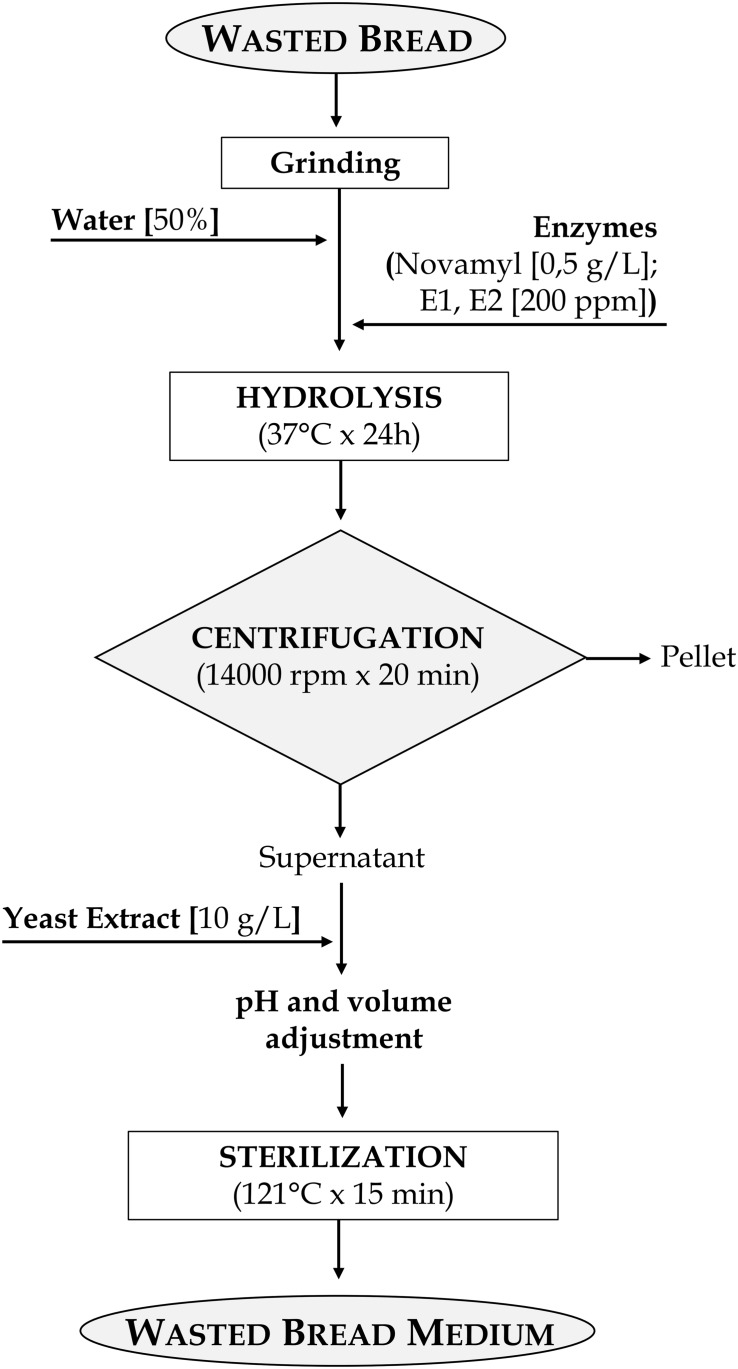
Flowchart of the protocol for the production of wasted bread medium (WBM).